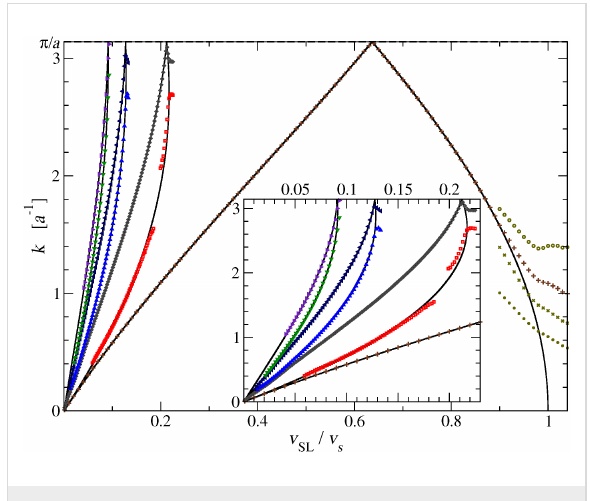
Figure 13: The positions of the observed peaks of (symbols), compared with the values of k of the phonons whose phase velocity is equal to v SL (black solid lines), solutions of Equation 13. Inset: a blow up of the interval 0 ≤ v SL ≤ 0.23 v s .